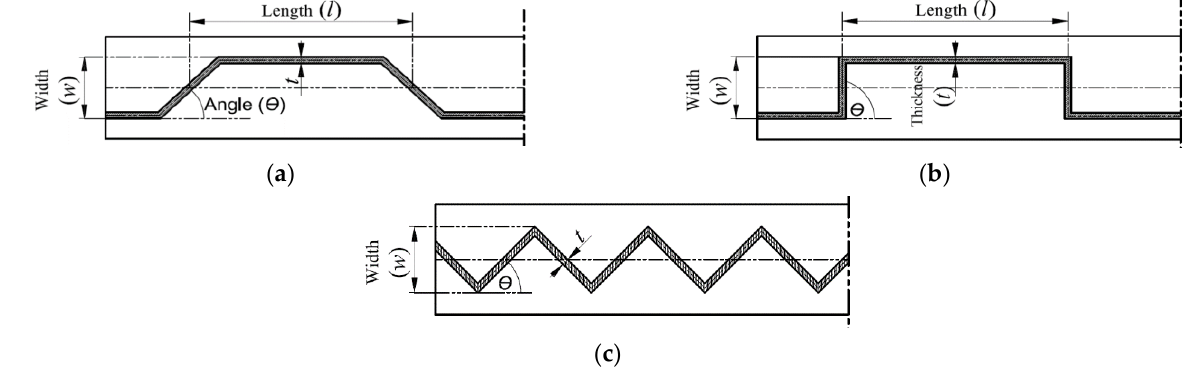
Figure 3. Corrugated web shapes and location of the abbreviations used: ( a ) Trapezoidal web, ( b ) rectangular web, and ( c ) triangular web. Table 1. List of flat and corrugated steel web beams assessed using FE modeling.